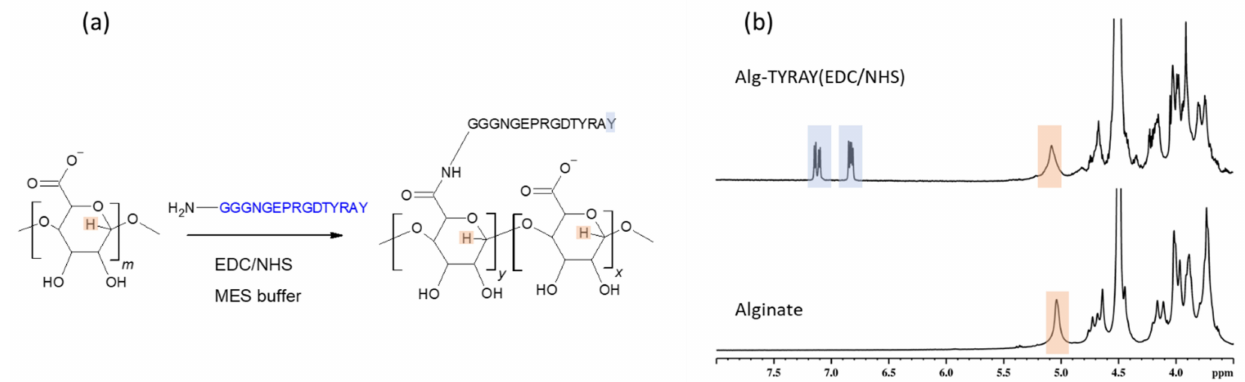
Figure 1. Peptide conjugation to alginate with help of EDC/NHS coupling. ( a ) scheme of the reaction; ( b ) 1 H NMR spectrum of sodium alginate measured in D 2 O at 50 ◦ C (bottom); 1 H NMR spectrum of Alg-TYRAY(EDC/NHS) measured in D 2 O at 50 ◦ C (top). Specific signals proving the modification are marked with